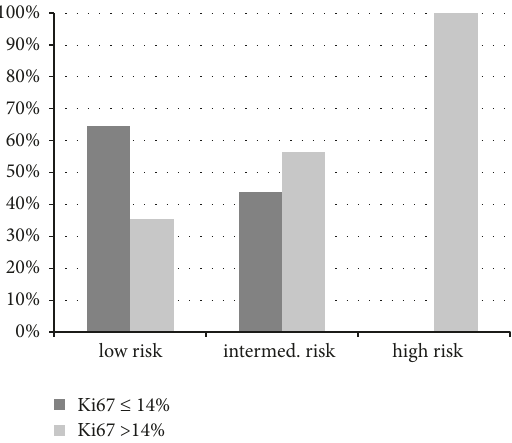
Figure 2: Index of Ki67 (%) within the risk groups.